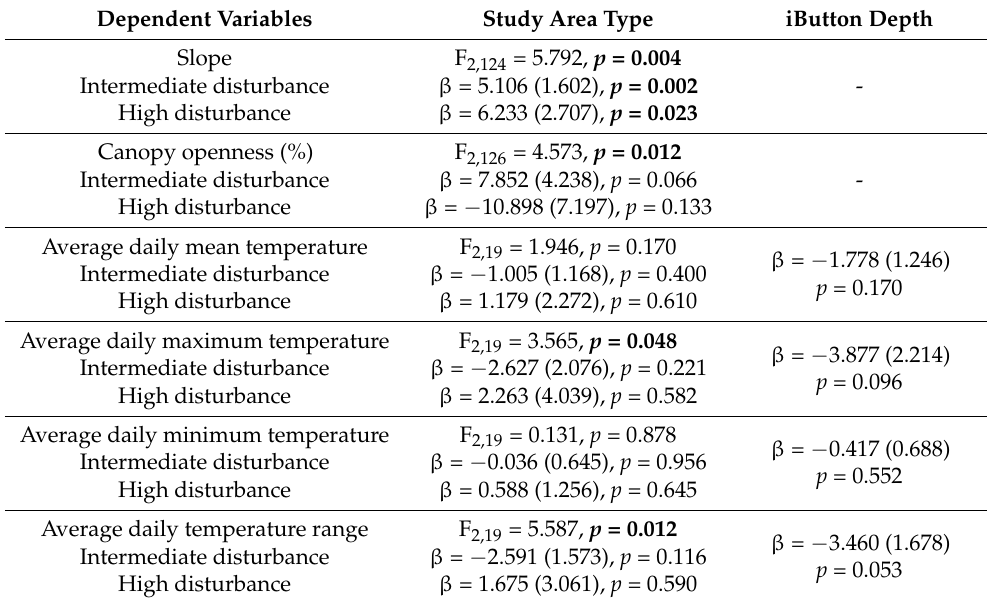
Table 3. Test statistics for comparisons of randomly selected locations (i.e., artificial nests) across three different types of study areas (high, intermediate, and low levels of human disturbance). Comparisons of temperature variables included iButton depth as an additional independent variable. For comparisons among study area types, effect sizes ( β ) were calculated using the low human disturbance area as the reference. Standard errors are indicated in parentheses, and statistically significant p values are in bold